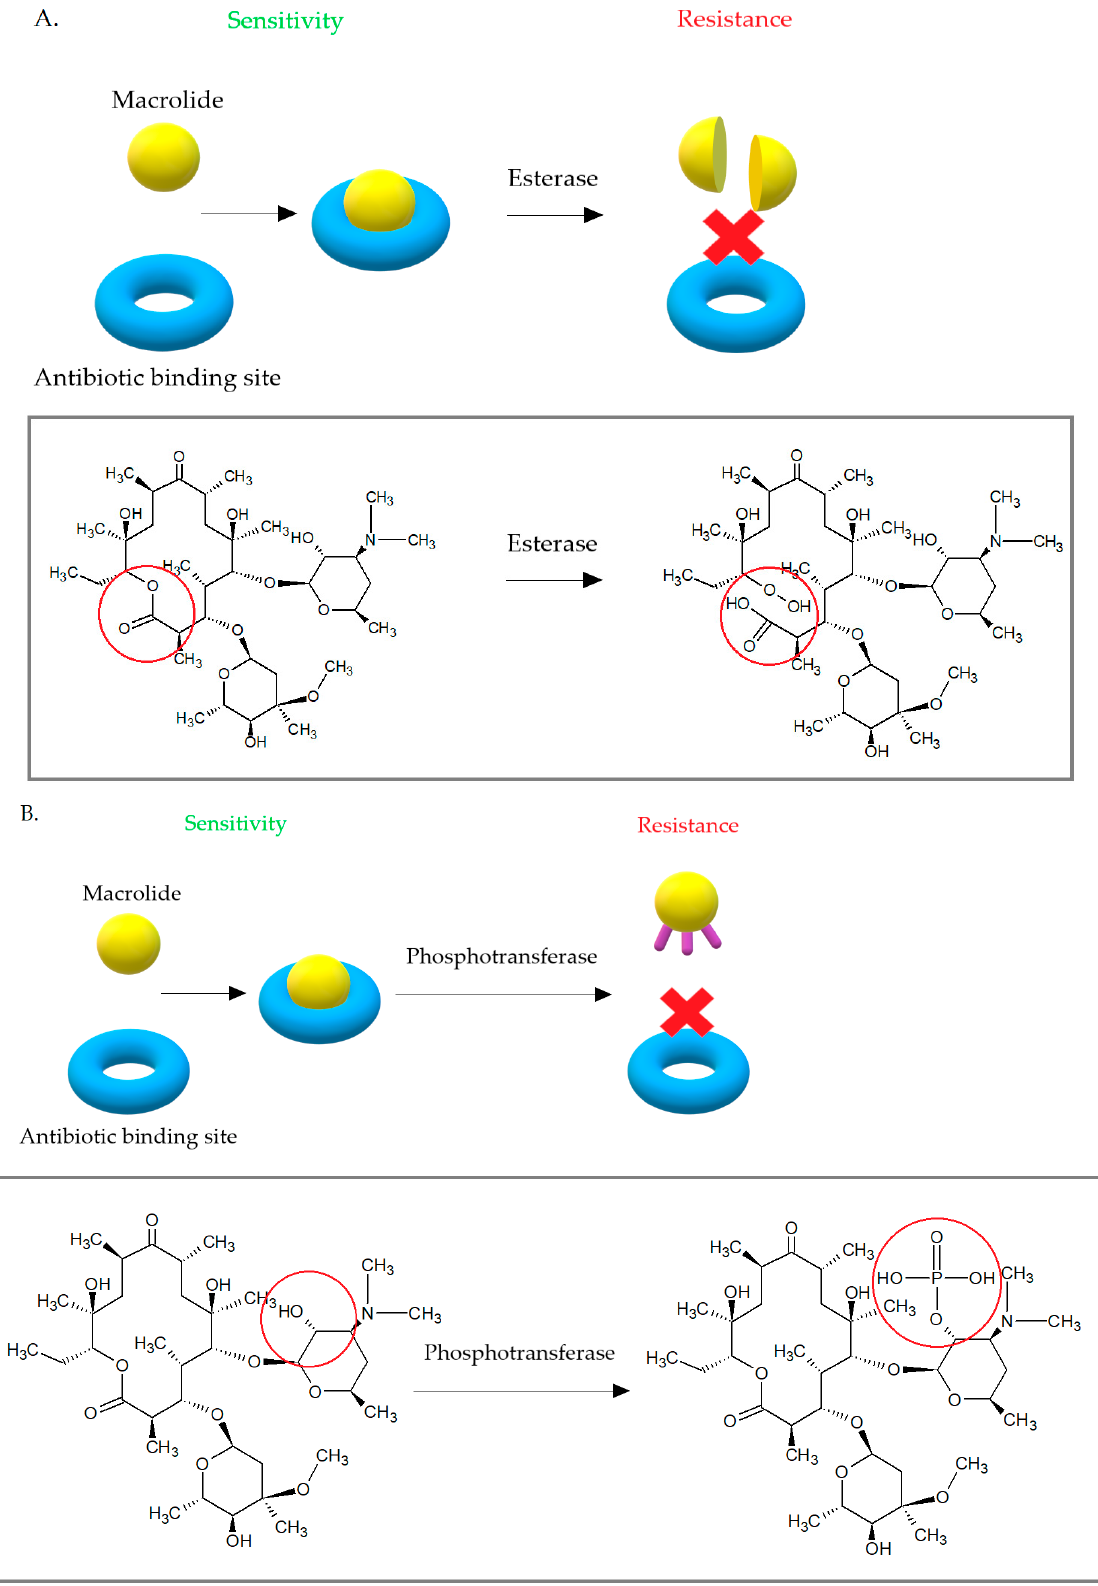
Figure 11. ( A ) Bacterial esterases cause hydrolysis of the erythromycin lactone ring, which prevents it from binding to the antibiotic target site. ( B ) Phosphotransferases introduce phosphate to the 2 ′‐ hydroxyl group of desosamine, which interferes with the interaction of the antibiotic with A2058.